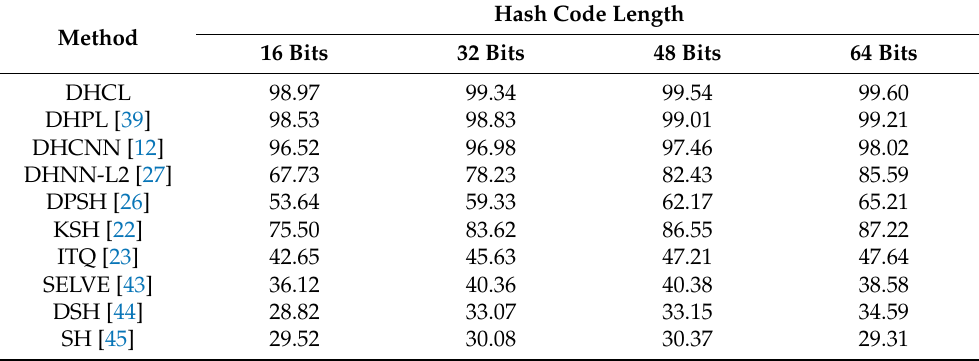
Table 1. Results of different retrieval methods on UCMD. The latest hash methods, including DHPL, DHCNN, DHNN-L2 and DPSH, and KSH, ITQ, SELVE, DSH and SH are compared with our DHCL method. The respective lengths of the hash codes used for retrieval are set to 16 bits, 32 bits, 48 bits and 64